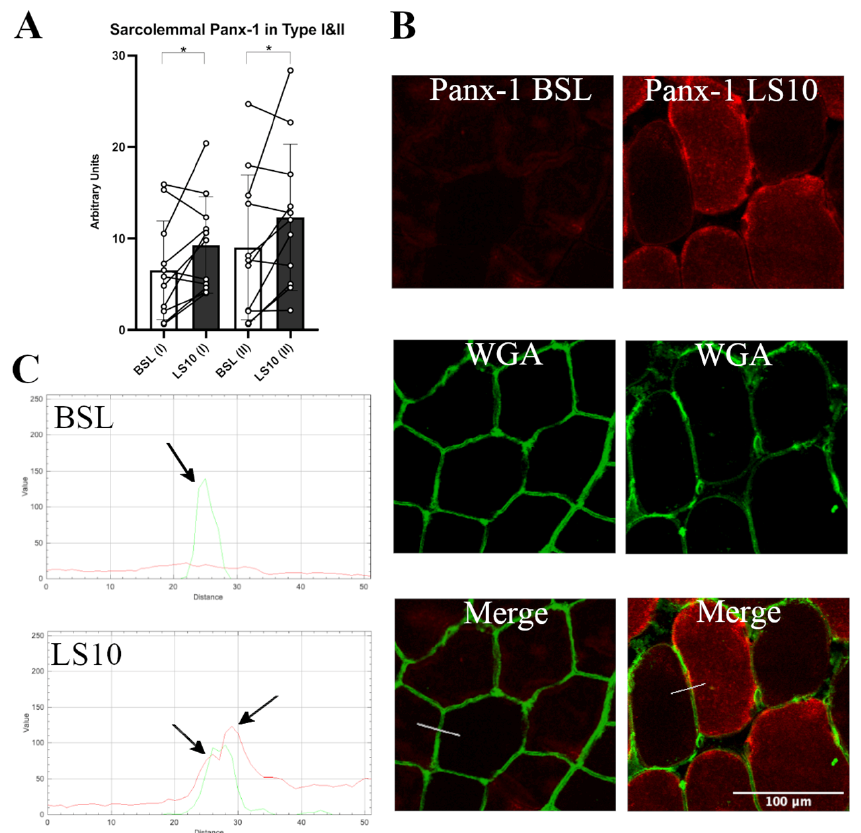
Figure 4. ( A ) Quantification of sarcolemma Panx-1 fluorescence in Type I and Type II (IIA + IIX) myofibers for baseline and after 10 days of ULLS. With (I) and (II) on the x-axis, the corresponding fibre type is indicated. Error bars represent standard deviations. Asterisks (*) indicate statistical significance at p < 0.05. ( B ) Typical staining images of Panx-1 for BSL and after 10 days of ULLS. In the middle, the WGA signal detected N-acetylglucosamine and N-acetylneuraminic acid (sialic acid) residues of the sarcolemma. Below are the merges between the two channels. ( C ) RGB profiles of the immunostaining of Panx-1. A line (width 5) has been drawn on the merge images (shown as a white line in the merge images), and RGB profiles were detected along the line. The peaks indicated by the arrows represent the green peak of the WGA signal referring to the sarcolemma fluorescence and the two red peaks (left and right) referring to the Panx-1 staining on the sarcolemma of Type I and Type II myofibers, respectively. A red peak is present only in the ULLS staining, proving its sarcolemmal upregulation. n = 11 male subjects; paired two-tailed t -test. Confocal microscope Leica SP5; 20 ×